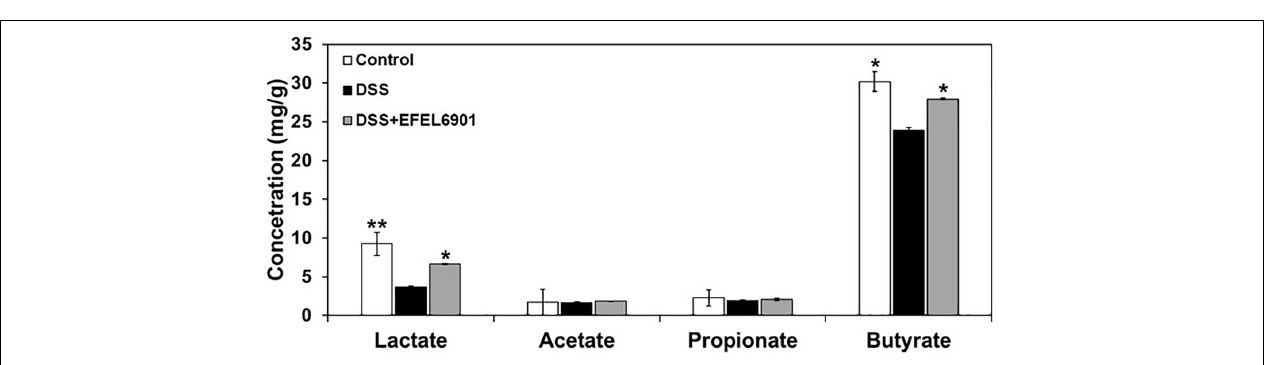
caused by DSS and could potentially be restored by EFEL6901